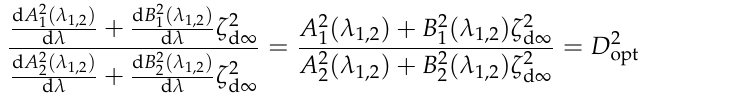
Thus, the optimal tuning damping ratio ζ d ∞ 1,2 , corresponding to the fixed points at λ 1 and λ 2 , are given by Equation (14).